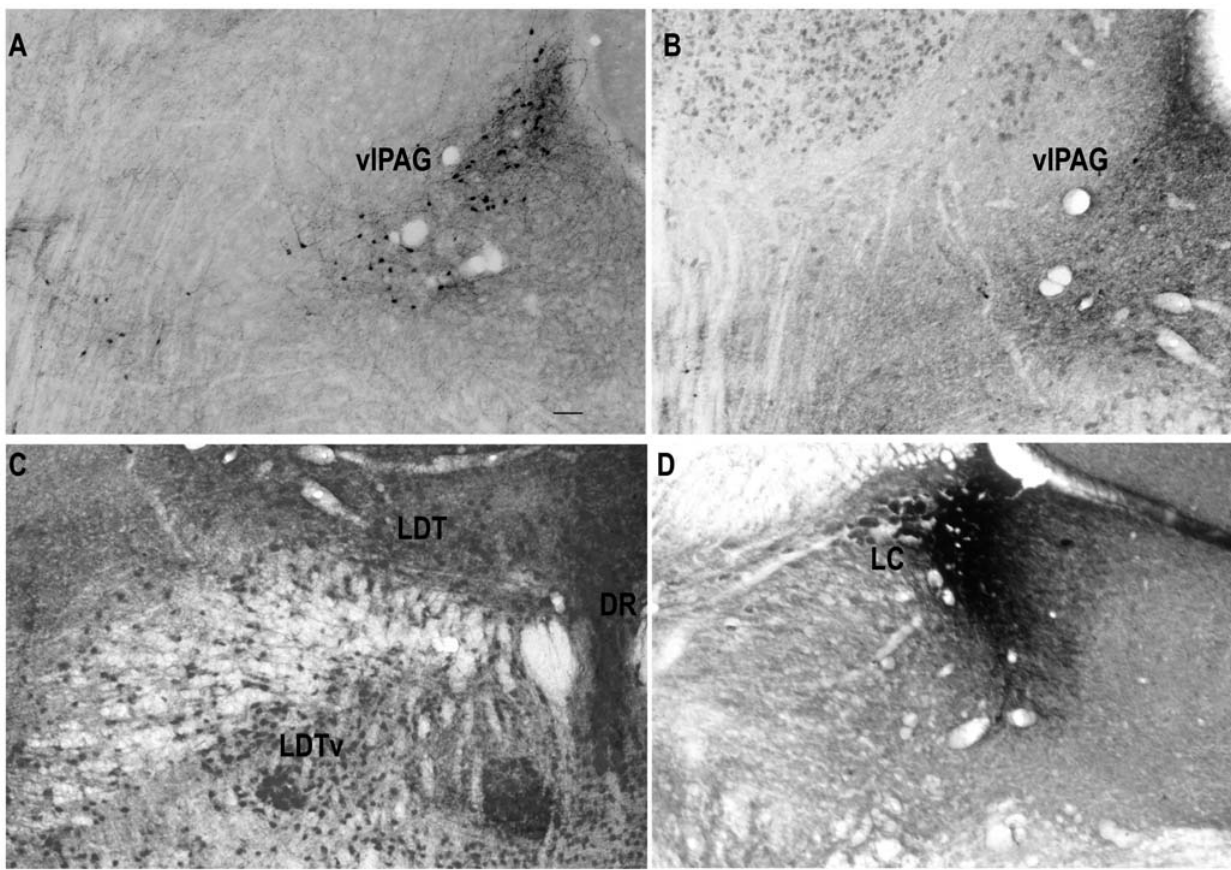
Figure 9. Photomicrographs showing the loss of the GFP neurons in the control (A) and lesioned FVB-GFP mouse (B). The cells in the lateral dorsal tegmental area (LDT) and medial dorsal raphae (DR) are spared by the lesions as shown by the NeuN staining (C), Similarly the noradrenergic neurons of the locus coeruleus (D) are also spared by the lesion. Scale 2 50 m m.